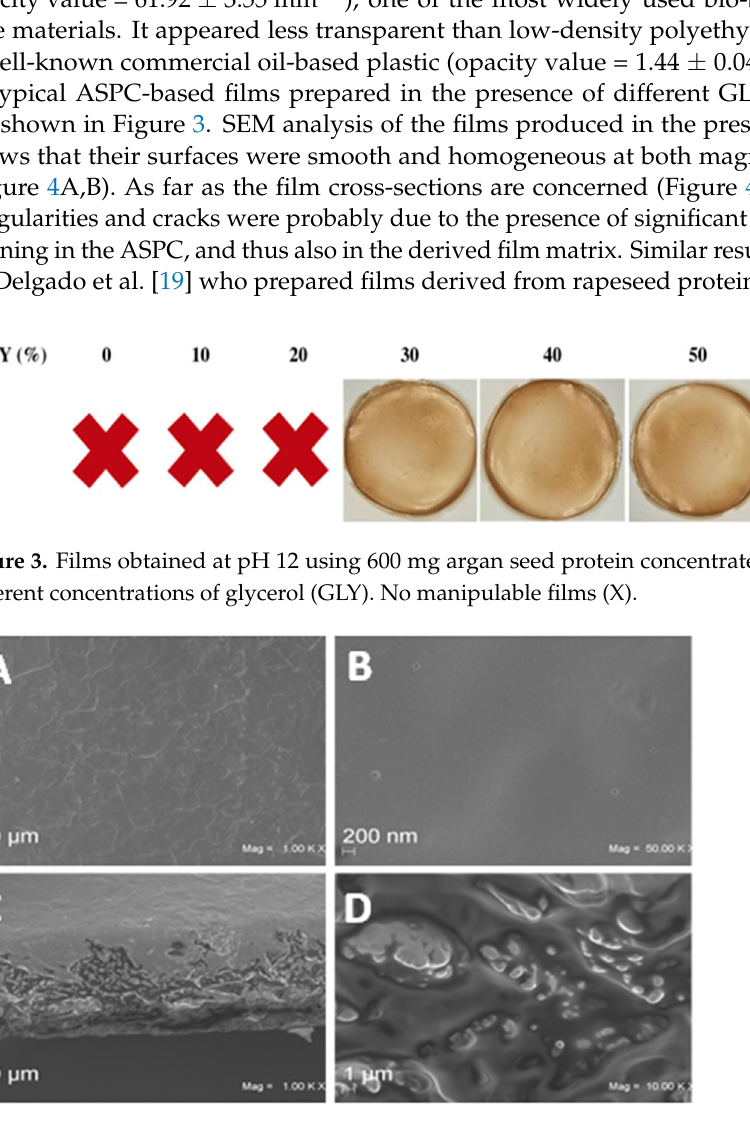
Figure 4. SEM images of argan seed protein concentrate (ASPC)-based films prepared by using 600 mg ASPC in the presence of 50% GLY. Film surfaces ( A , B ) and cross-sections ( C , D ) were observed at different magnifications: ( A ) 1000×; ( B ) 50,000×, ( C ) 1000×,and ( D ) 10,000×. Further experimental details are given in the text.